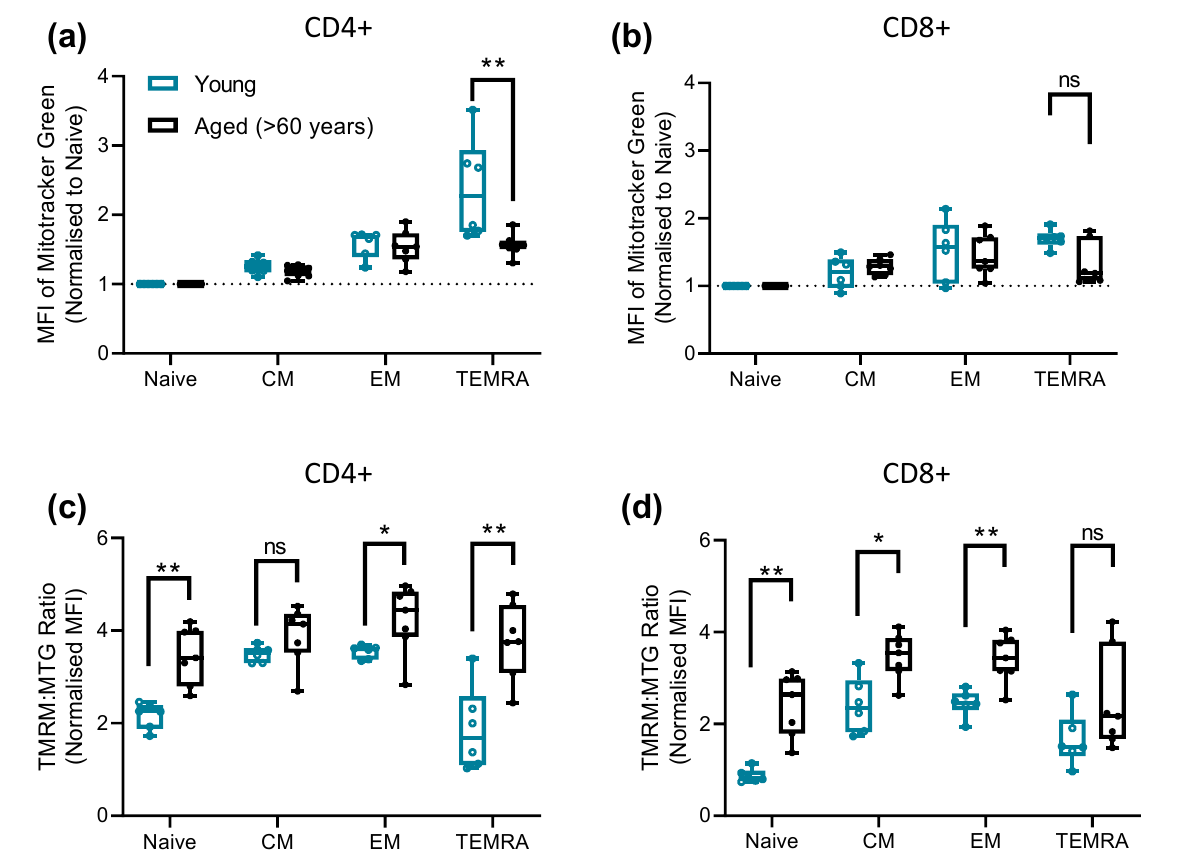
Figure 4. Age-associated differences in mitochondrial mass are unique to the CD4 TEMRA subset. Flow cytometry analysis was used to compare MitoTracker Green staining between ( a ) CD4+ T cell subsets and ( b ) CD8+ T cell subsets. Flow cytometry analysis was used to compare mitochondrial membrane potential between ( c ) CD4+ T cell subsets and ( d ) CD8+ T cell subsets. ( a – d ) Mann–Whitney test was used to test for significant differences between young ( n = 6; average age = 30.1 years) and aged ( n = 7; average age = 71.2 years) for each T cell subset. Data presented in boxplots; ns = non-significant, * p < 0.05 ** p < 0.01).